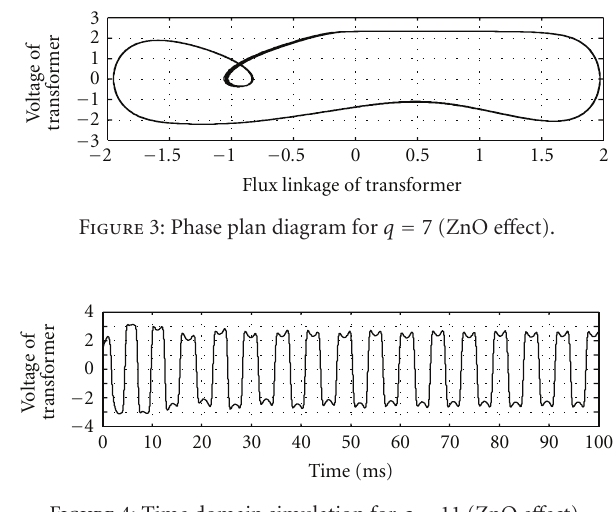
Figure 4: Time domain simulation for q = 11 (ZnO e ff ect).